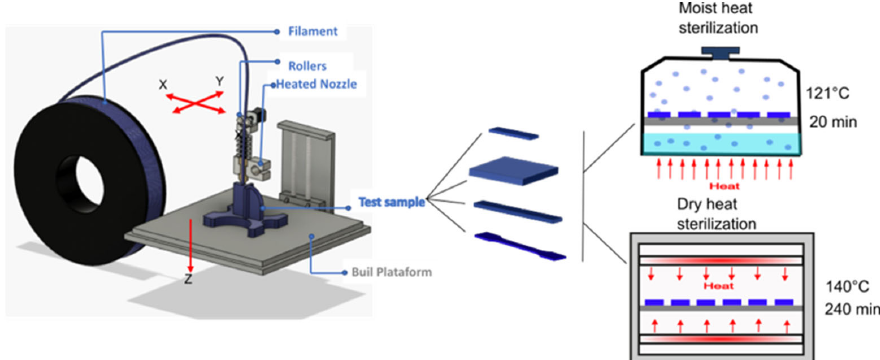
Figure 1. Schematic representation of the 3D ‐ printing process followed by the sterilization processes.